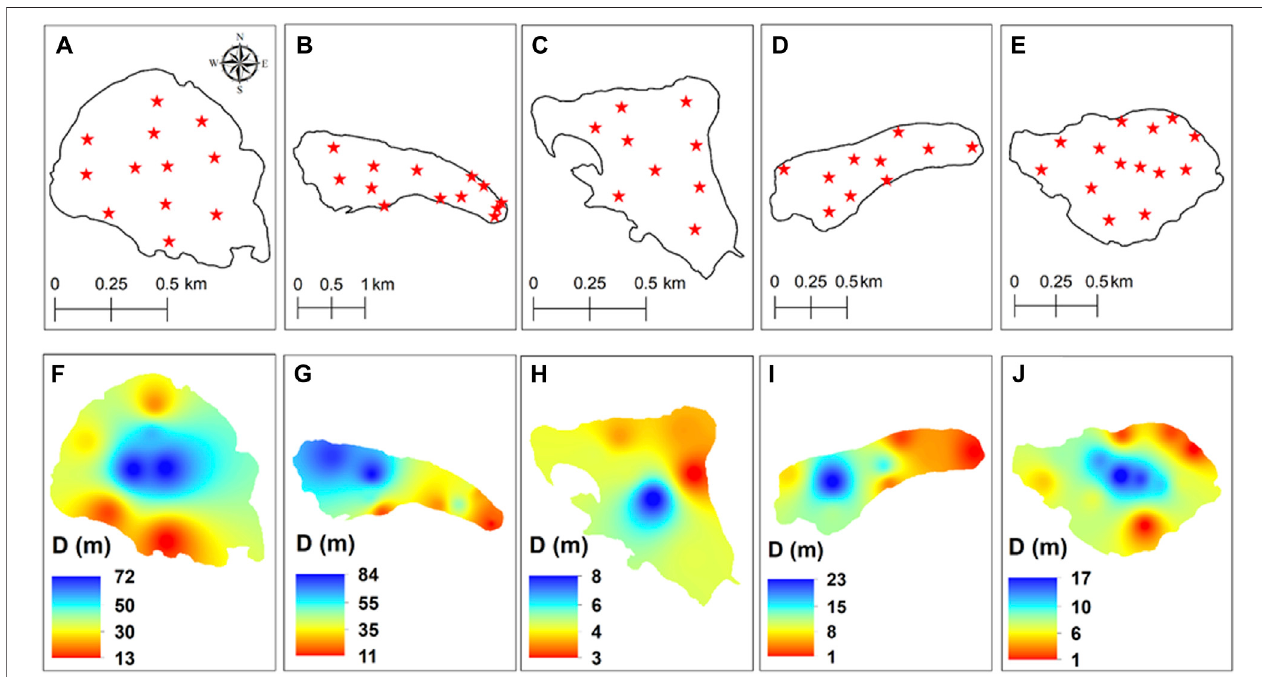
FIGURE 2 | Bathymetry locations for measuring the depth of the lakes (A) Gadsar, (B) Gangbal, (C) Kishansar, (D) Nundkol, and (E) Vishansar and interpolated bathymetric maps of lakes (F) Gadsar, (G) Gangbal, (H) Kishansar, (I) Nundkol, and (J) Vishansar.